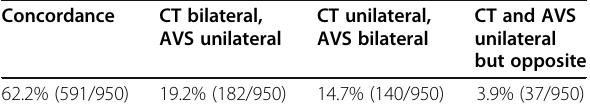
Table 2 Discordance between AVS and cross sectional imaging according to meta-analysis performed in 2009 which included 38 studies and 950 patients. (Kempers et al. 2009). In cases where CT is non-lateralizing (either because both glands are normal or both glands are abnormal) but AVS is lateralizing, patients would have been inappropriately excluded from potentially curative surgery. In cases where CT suggests unilateral production but AVS shows bilateral production, patients would be subjected to inappropriate surgery. Finally, in cases where CT demonstrates unilateral pathology but AVS demonstrates contralateral pathology, these patients would have undergone wrong side surgery